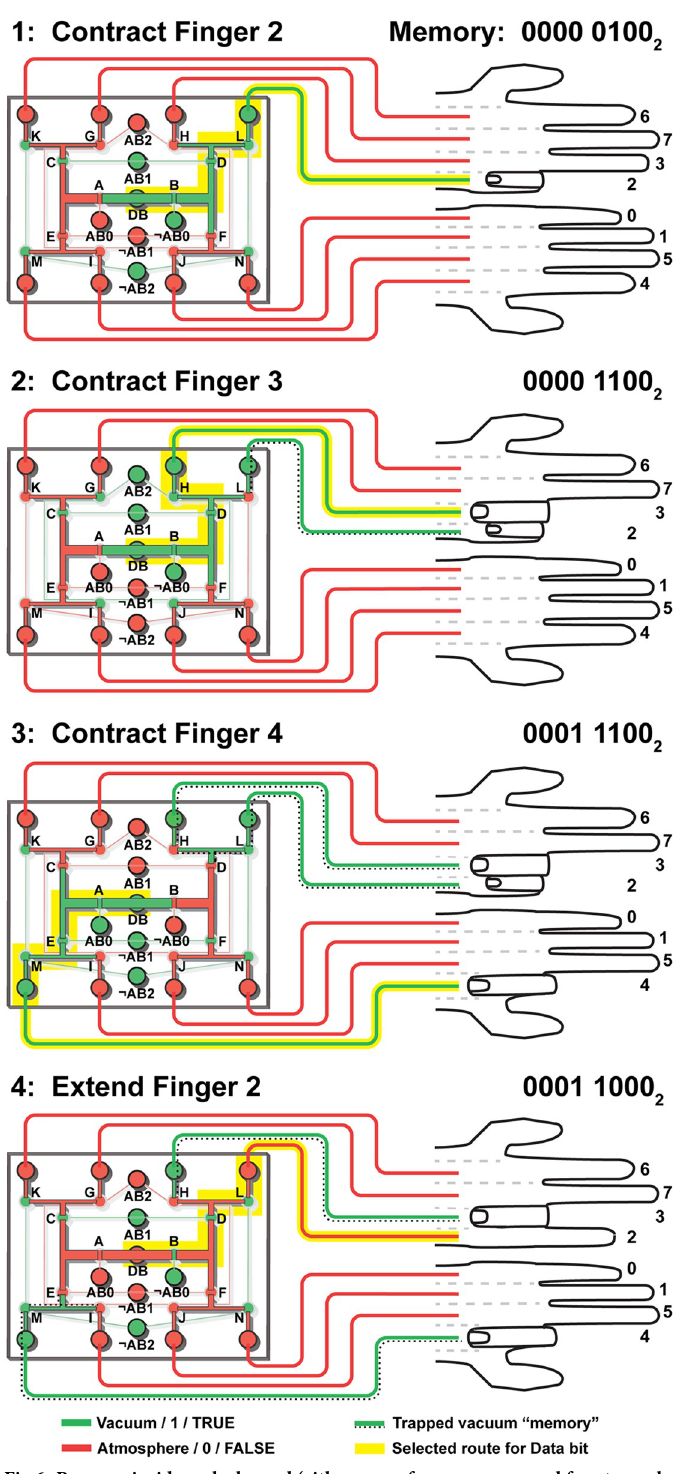
Fig 6. Pressure inside each channel (either green for vacuum, or red for atmospheric pressure) while using the pneumatic eight-bit RAM to contract and extend several soft robotic fingers. In each step, the vacuum or pressure applied to the Address bits (AB0, AB1, AB2, and their negations ¬ AB0, ¬ AB1, ¬ AB2) determine the route (highlighted in yellow) followed by the Data bit (DB) signal to the selected finger. Channels containing trapped vacuum “memories” are marked using a dotted line, and the binary representation of the contents of the pneumatic RAM is